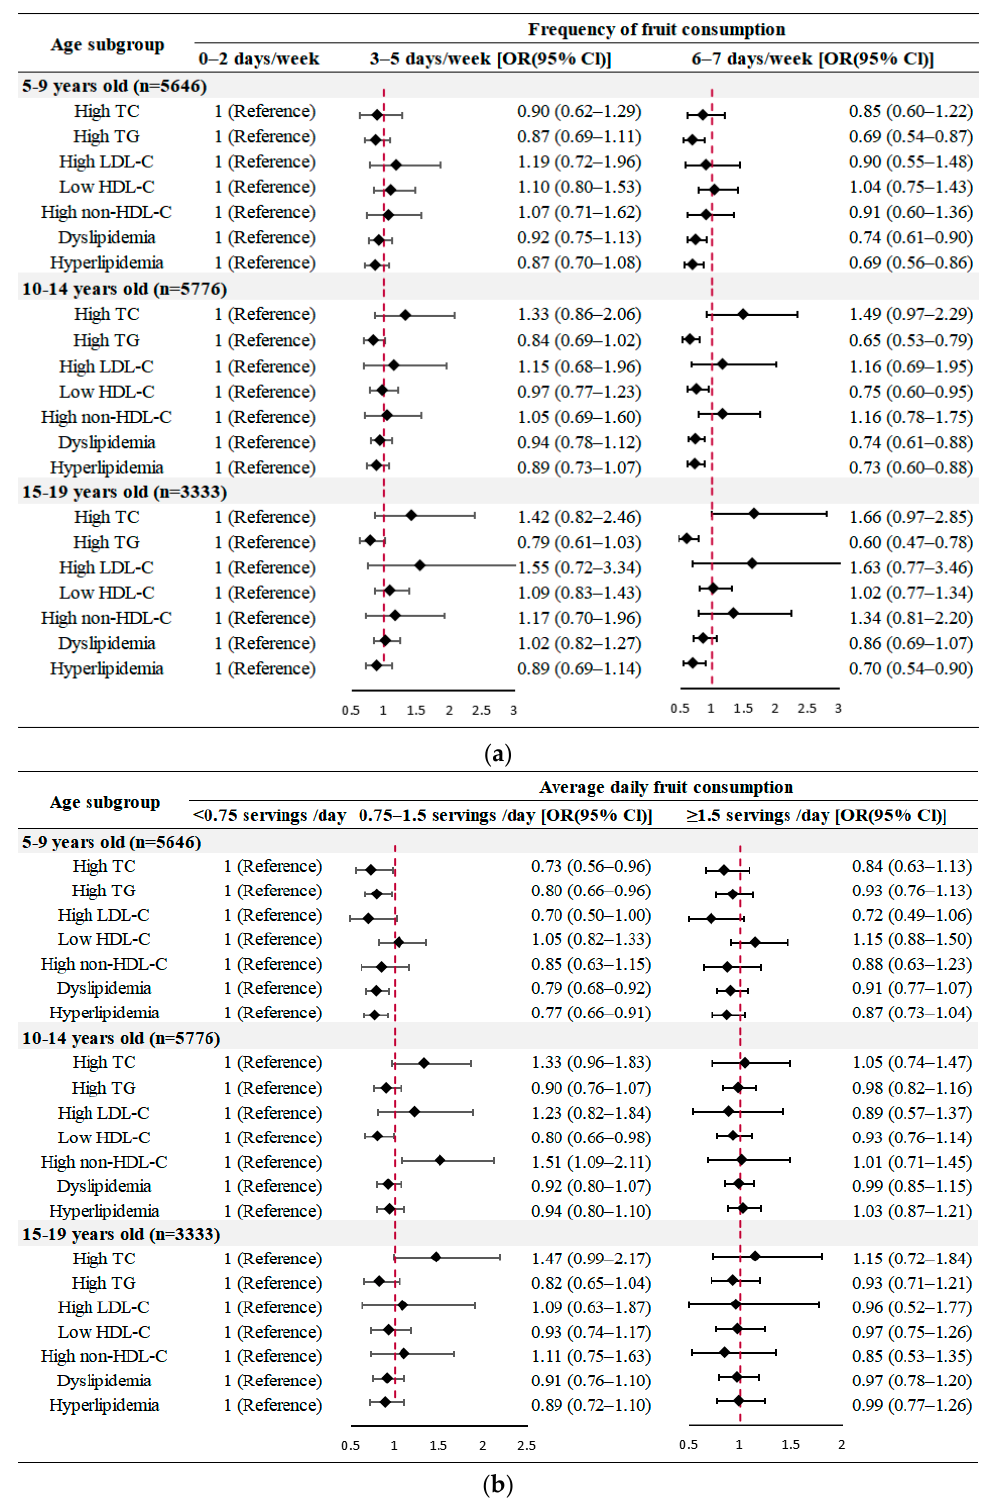
Figure 1. Sex-specific analysis of the associations between fruit consumption and lipid profile (ad- justed for age, BMI values, residence area, ethnicity, incomes, parental educational attainment, pa- rental weight, vegetable consumption, sugar-sweetened beverages consumption, meat consump- tion and physical activity) ( a ) Frequency of fruit consumption; ( b ) Average daily fruit consumption. TC, total cholesterol; TG, triglycerides; LDL-C, low density lipoprotein-cholesterol; HDL-C, high density lipoprotein-cholesterol; diamond symbol, point estimates; red dashed line, invalid line.